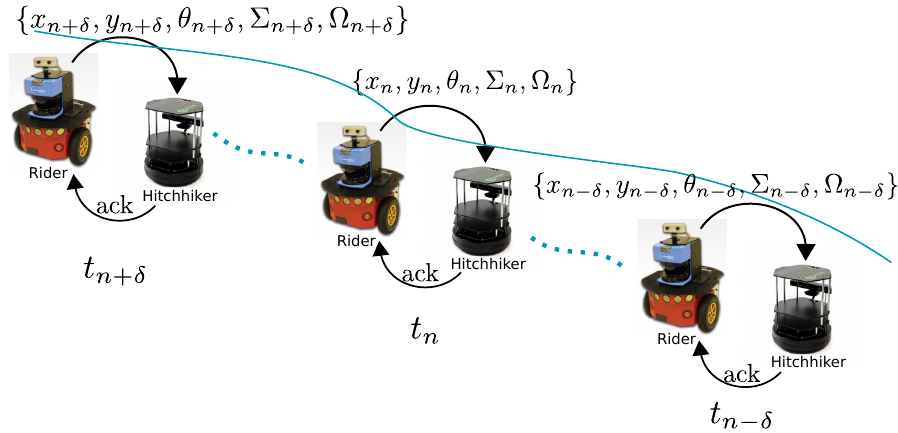
Figure 5. Intermittent information transfer from driver every δ time-steps to recover from ‘driver-lost’